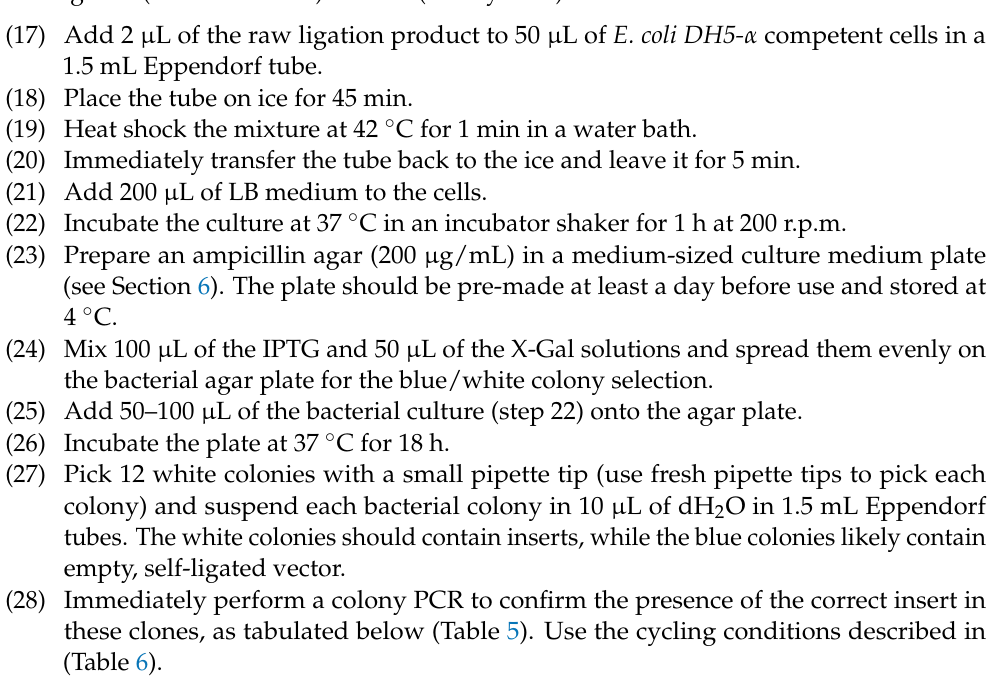
Table 5. Reaction mix for colony PCR.